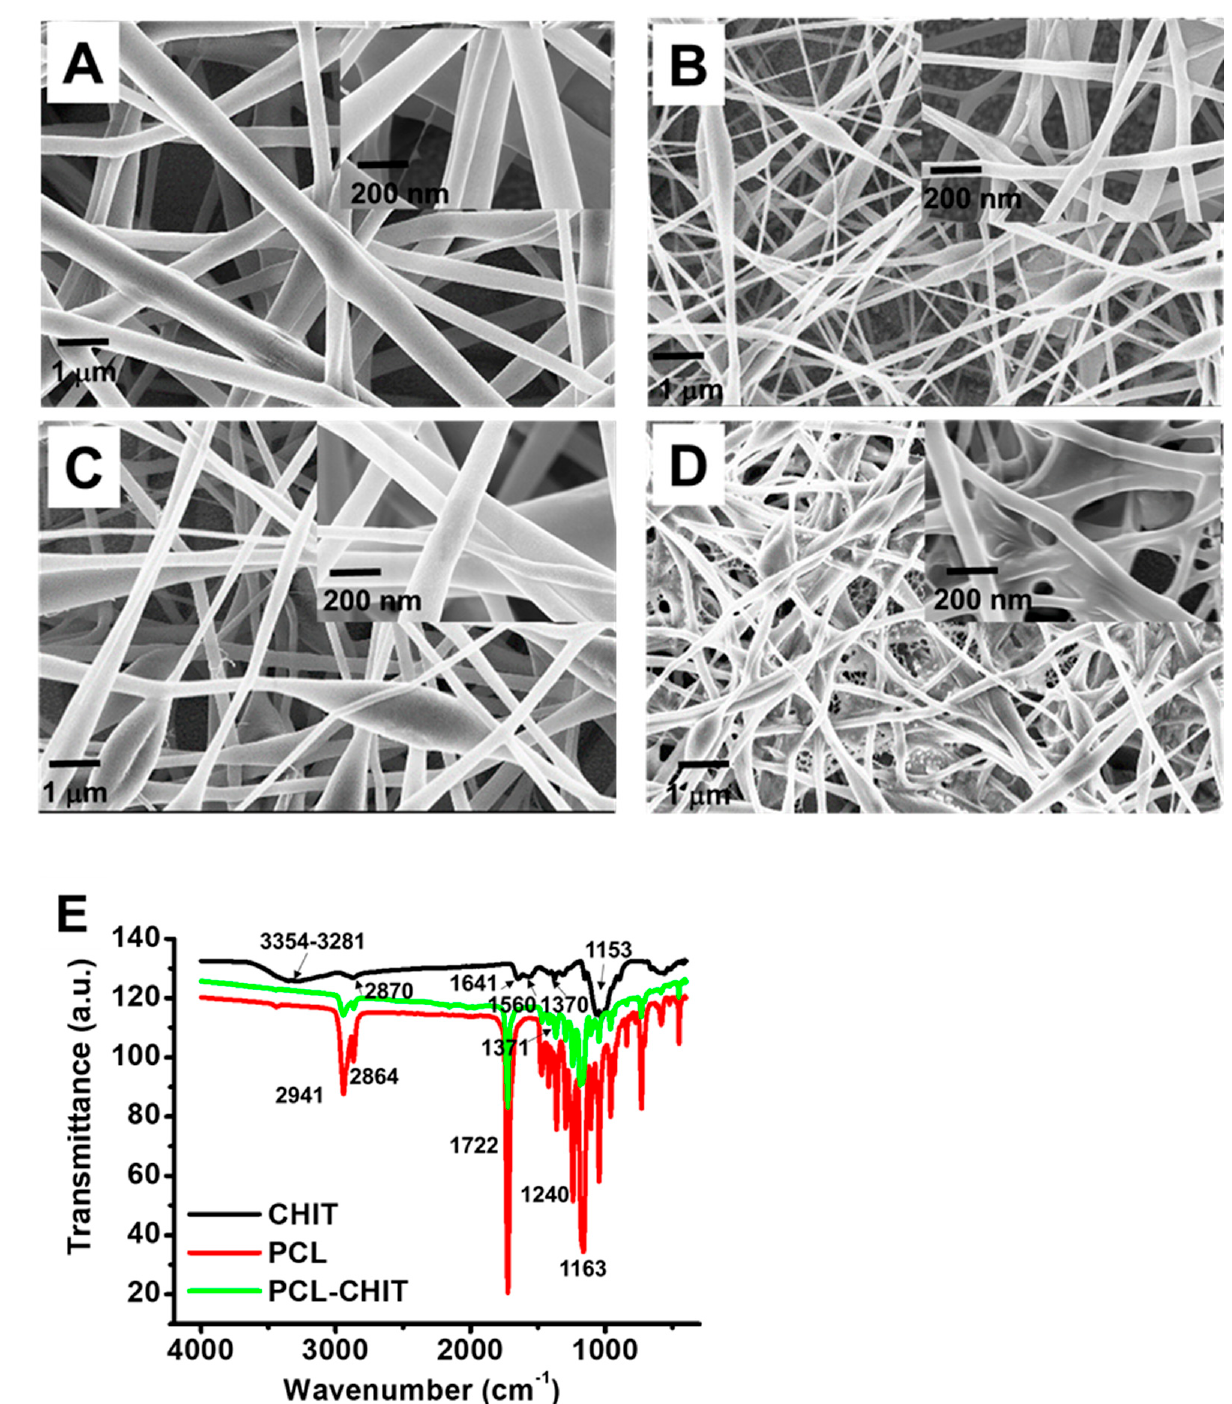
Figure 2. SEM images of ( A ) PCL–CHIT, ( B ) PCL–CHIT/Mt, ( C ) PCL–CHIT/PAMAM G1 –Mt, and ( D ) PCL–CHIT/PAMAM G1 –Mt/GluO x (insets show the higher-magnification SEM images). ( E ) FTIR spectra of PCL, CHIT, and PCL–CHIT ENFs.